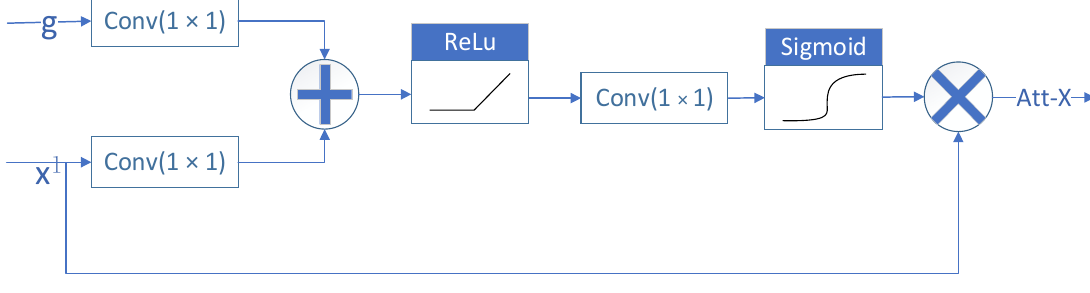
Figure 6. Structure of attention module.